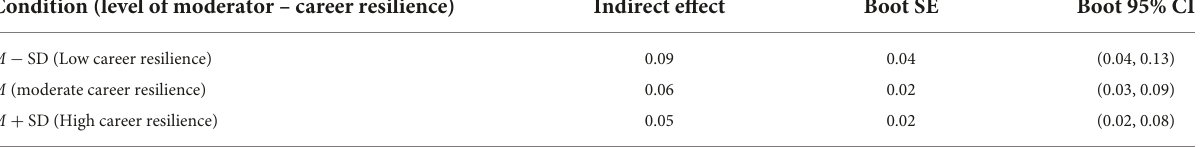
TABLE 4 Results for conditional indirect effect across levels of relational